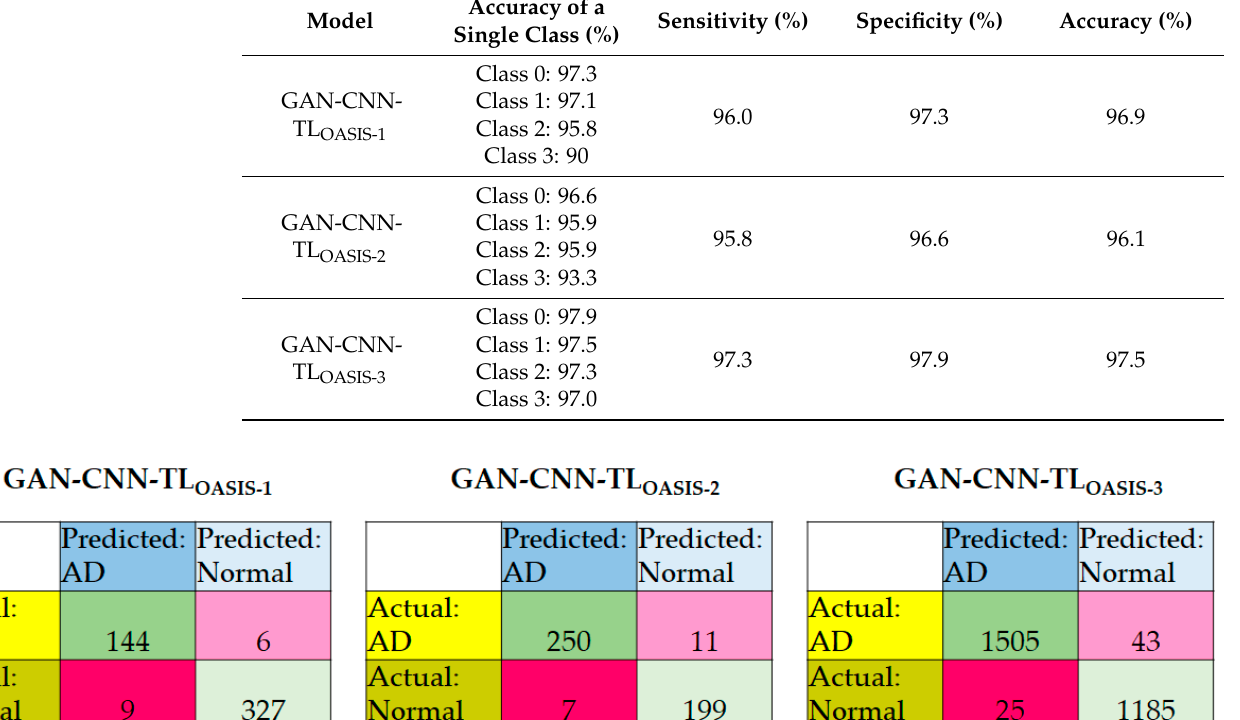
Table 5. Performance evaluation of the GAN-CNN-TL for OASIS-1, OASIS-2, and OASIS-3.